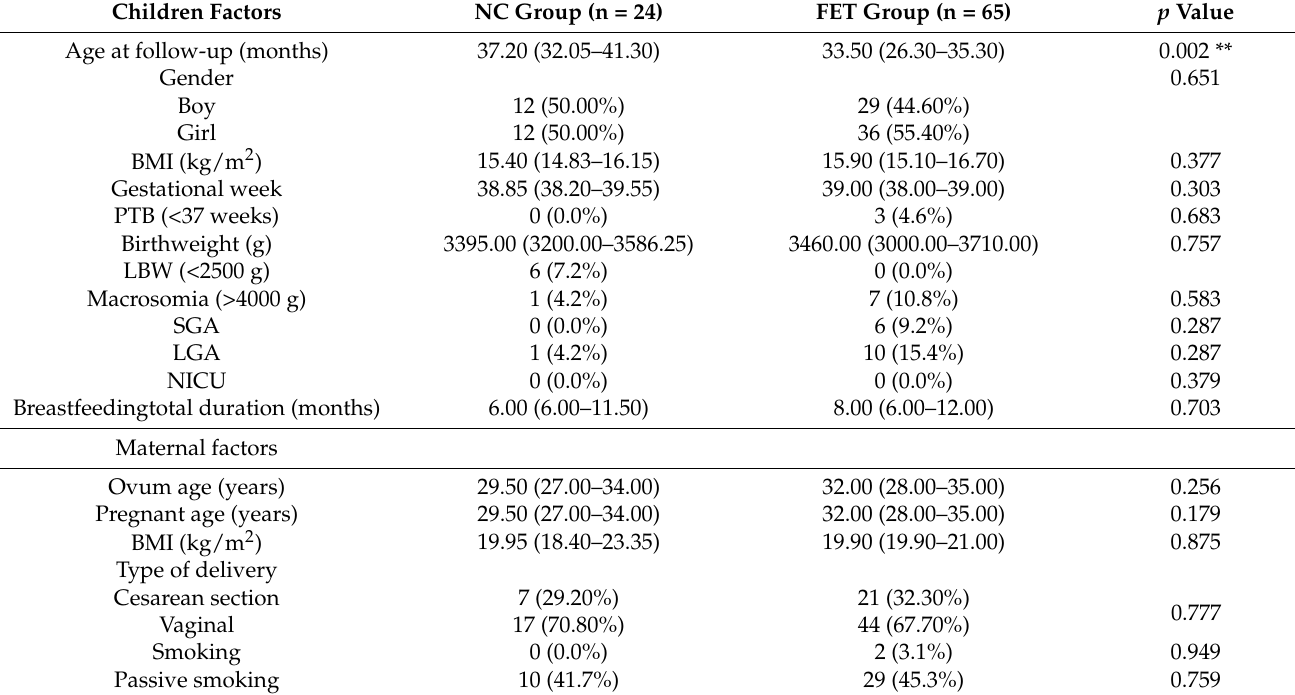
Table 1. Baseline characteristics of singleton children and their parents in the